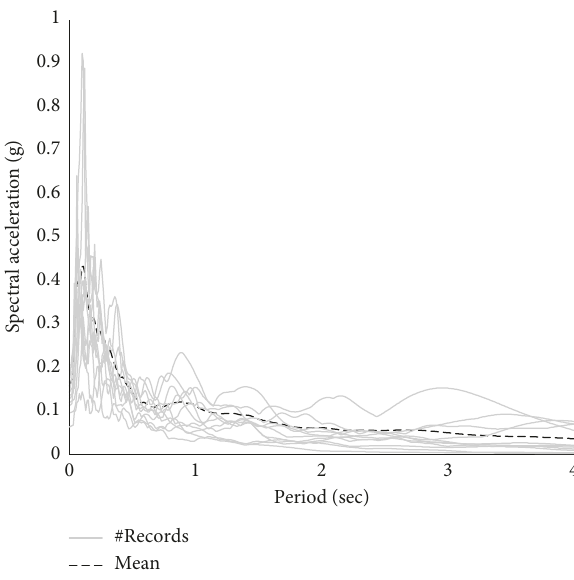
Figure 5: Elastic response spectral acceleration for far-field records.